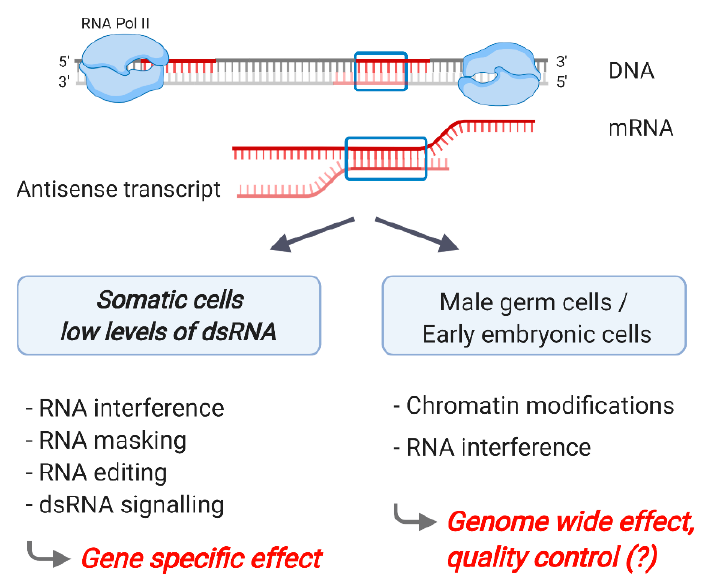
Figure 2. Double-stranded RNA (dsRNA) formation from sense–antisense transcripts. Natural antisense transcripts are processed and potentially reach the cytoplasm, where they interact with the sense transcript. In somatic cells, the level of sense–antisense hybrids is low, and there is no evidence of ADAR editing, for example, nor is dsRNA immune signaling triggered. Various mechanisms (RNA interference, RNA masking, RNA editing and dsRNA signaling) are potentially triggered by the dsRNA, depending on the cellular context. In male germ cells and during early embryogenesis, sense–antisense dsRNA formation may play a general, system-relevant role. Figure created with Biorender.com.